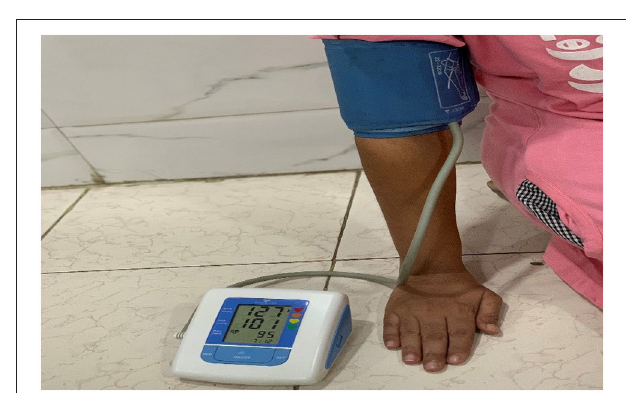
FIGURE 2 | Sphygmomanometer.